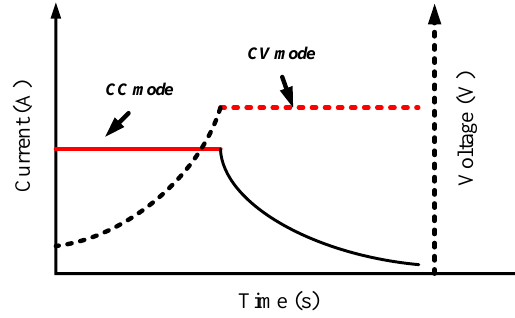
Figure 2. Process of lithium-ion battery cell charging.